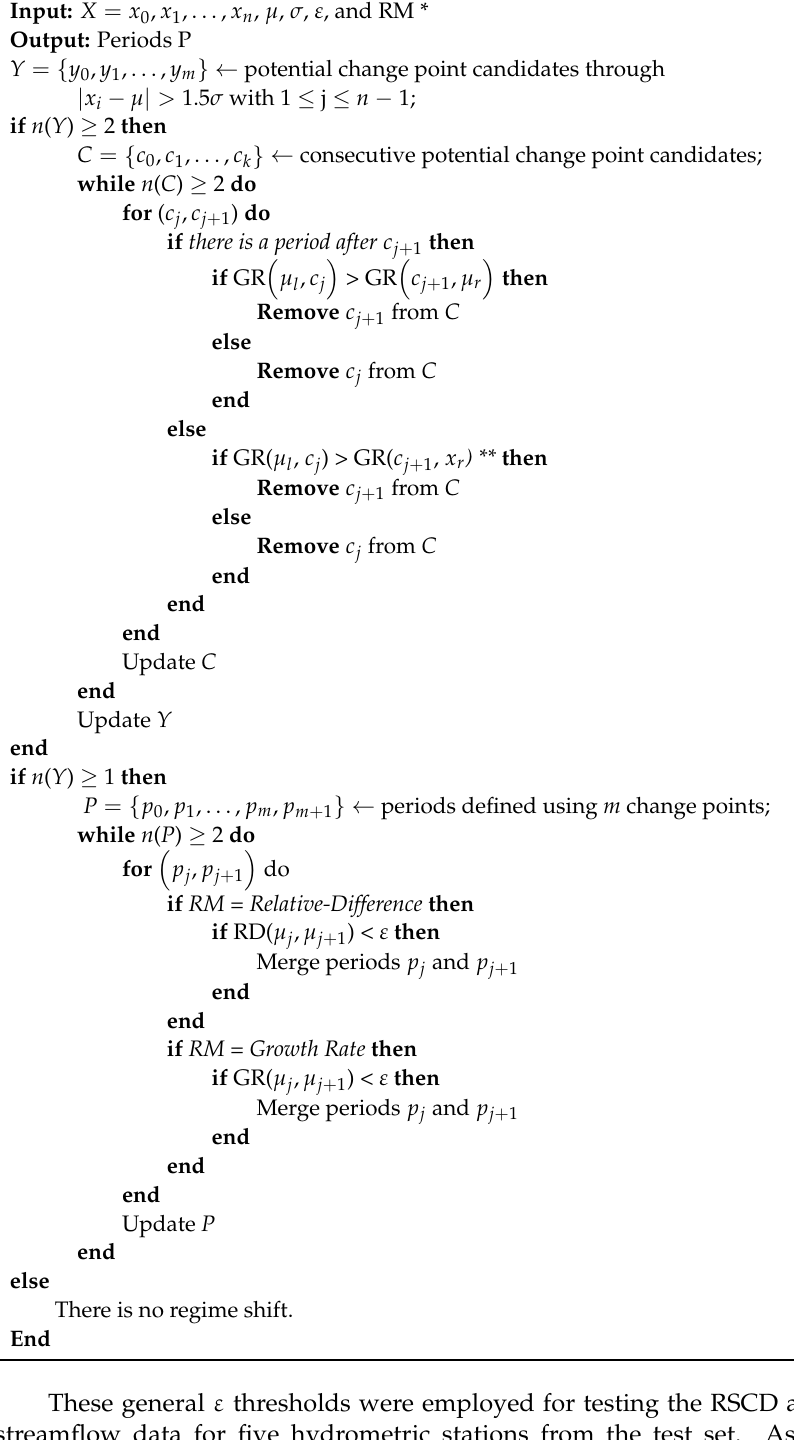
Algorithm 1 Regime Shift Change Detection (RSCD) algorithm, * Refine Method (RM).